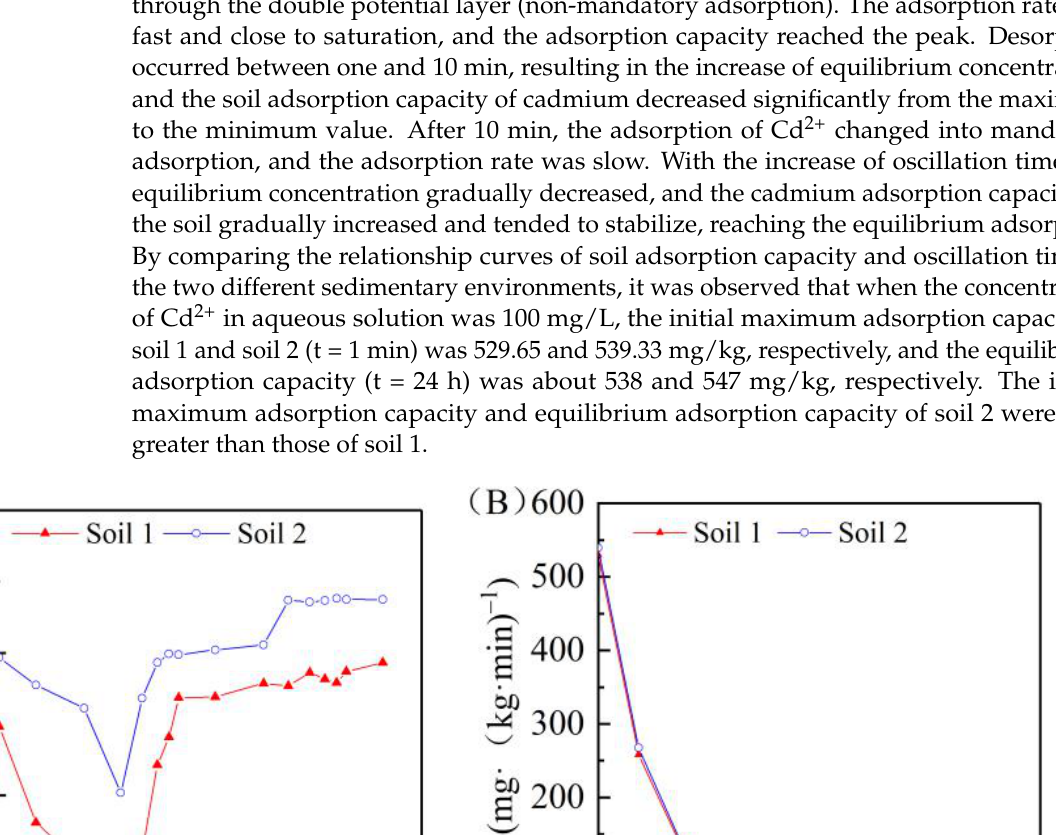
Figure 6. Elvoich equation fitting ( A ), biconstant equation fitting ( B ), and similar exponential as- ymptote equation fitting ( C ) for cadmium adsorption in the two soil types. 3.4. Effect of Solution pH Value on Cadmium Adsorption in Two Soils The adsorption behavior of cadmium in the two soils with different solution pH val- ues is shown in Figure 7 (cadmium solution concentration was 100 mg/L, water to soil ratio was 5.5:1). In general, the adsorption capacity increased as the pH became more al- kaline. When the pH of the cadmium solution was 3.5, the cadmium adsorption capacity was significantly lower compared with the other three pH values; while at a pH value of 9.5, the adsorption capacity was significantly higher. When the pH of the cadmium solu- tion was 4.5 and 5.5, the cadmium adsorption capacity was similar. The dynamic expo- nential asymptote equation was adopted to fit the adsorption kinetics of cadmium, as shown in Table 3: when the reaction time t tended to infinity, the saturation adsorption of